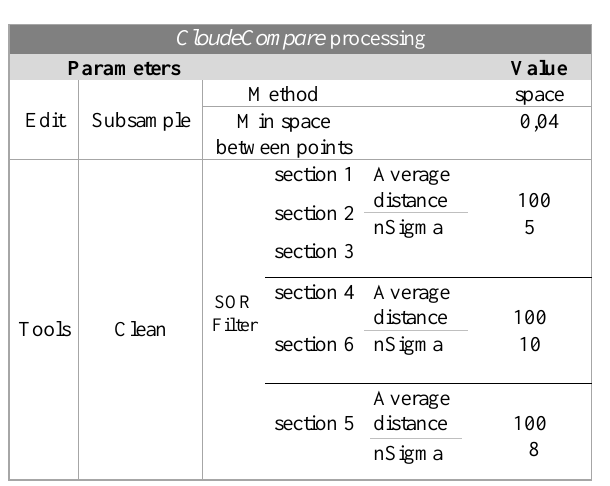
2 . Point cloud processing in CloudCompare .